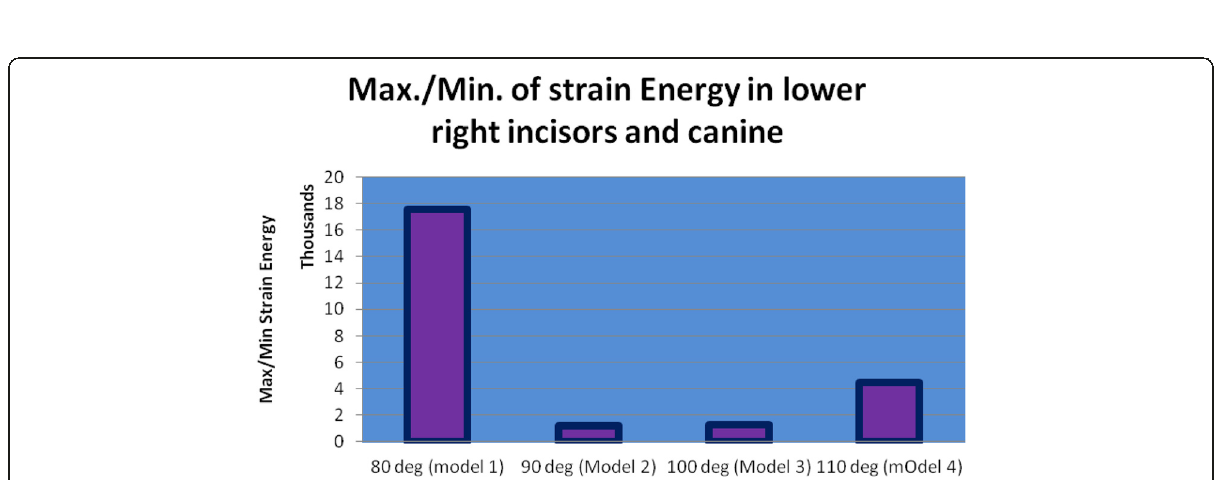
Fig. 12 Max./Min. of strain energy in the lower right incisors and the